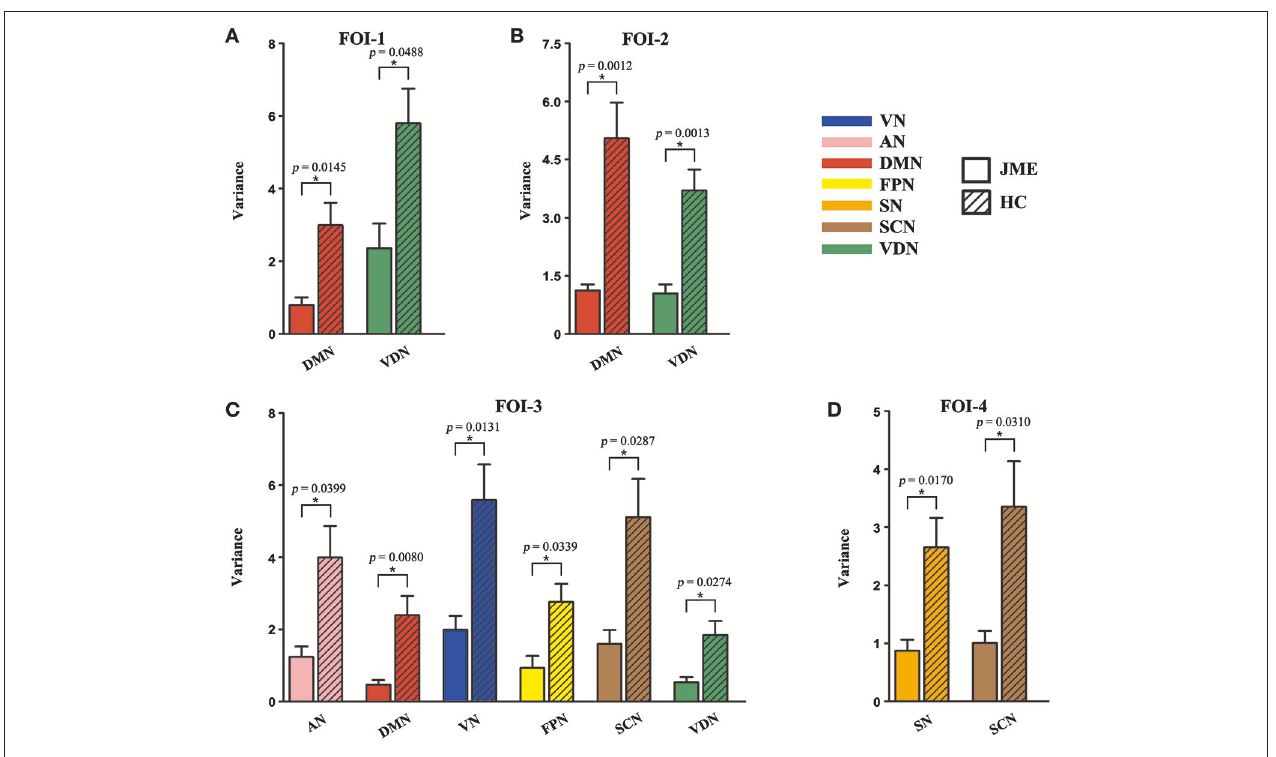
FIGURE 4 | Significant between-group differences in intra-RSN dynamics across FOI-1 (A) , FOI-2 (B) , FOI-3 (C) and FOI-4 (D) . Intra-RSN dynamics with significant group differences in each FOI are depicted for JME and HC with error bars. Asterisks indicate a significant group difference with two sample t- test, significant level was set at P < 0.05 for Bonferroni corrected.